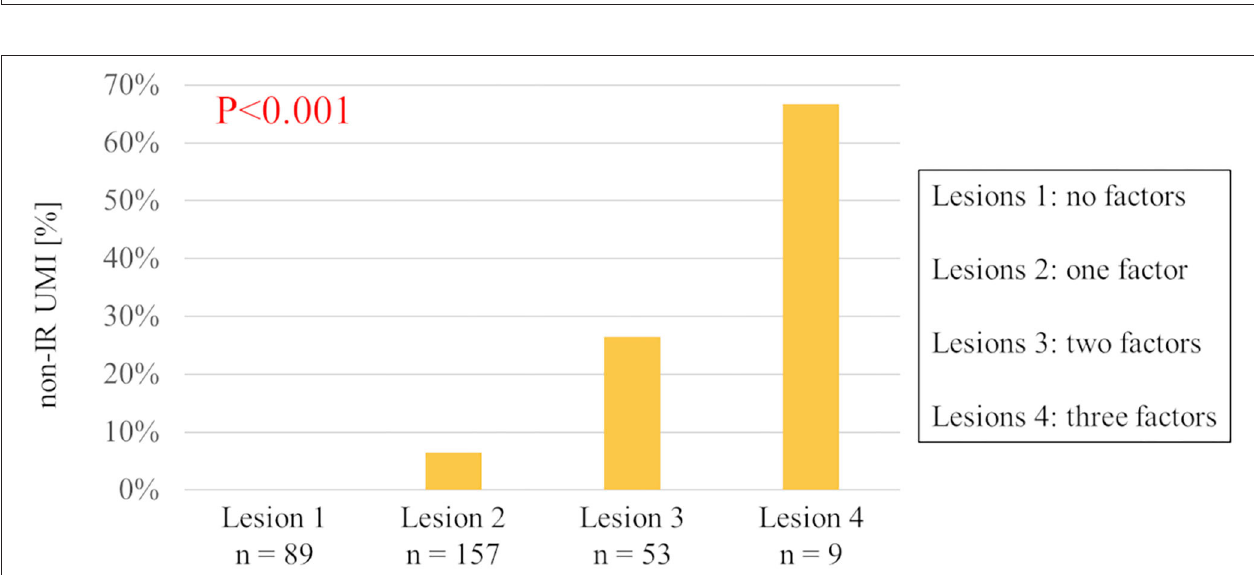
FIGURE 2 | Non-IR UMI volume stratified by the best cut-off values of FAI and CT-derived stenosis severity. Lesions with FAI > -64.3 and CT-derived stenosis > 55.2% showed higher non-IR LGE volume (non-IR UMI volume). Non-IR, non-infarct-related; UMI, unrecognized myocardial infarction; CT, computed tomography; LGE, late gadolinium enhancement; FAI, peri-coronary fat attenuation index.